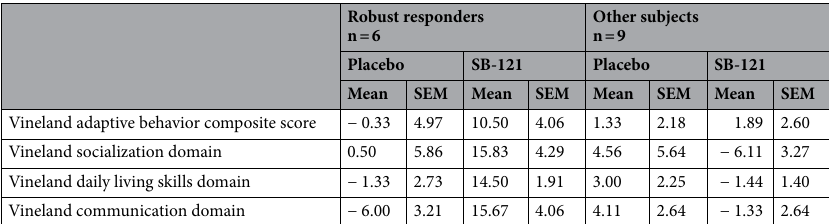
Robust responders n = 6